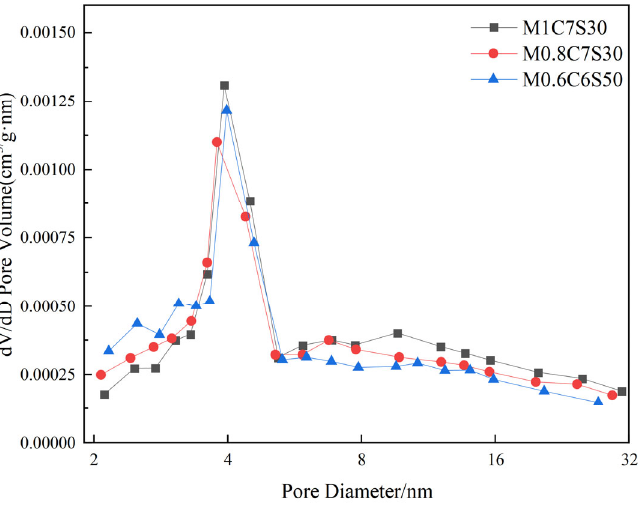
Figure 13. Pore diameter distribution of the soft soil stabilized using different mixture ratios.